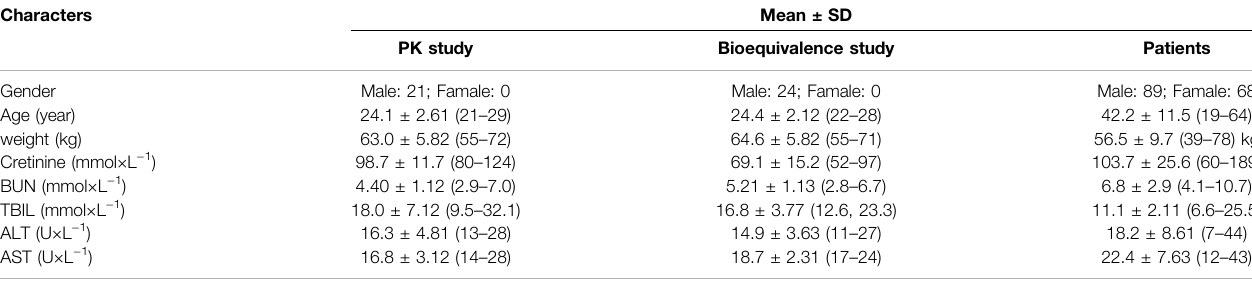
TABLE 1 | Demographic data of pharmacokinetic study on healthy subjects and tuberculosis patients. Characters Mean ± SD